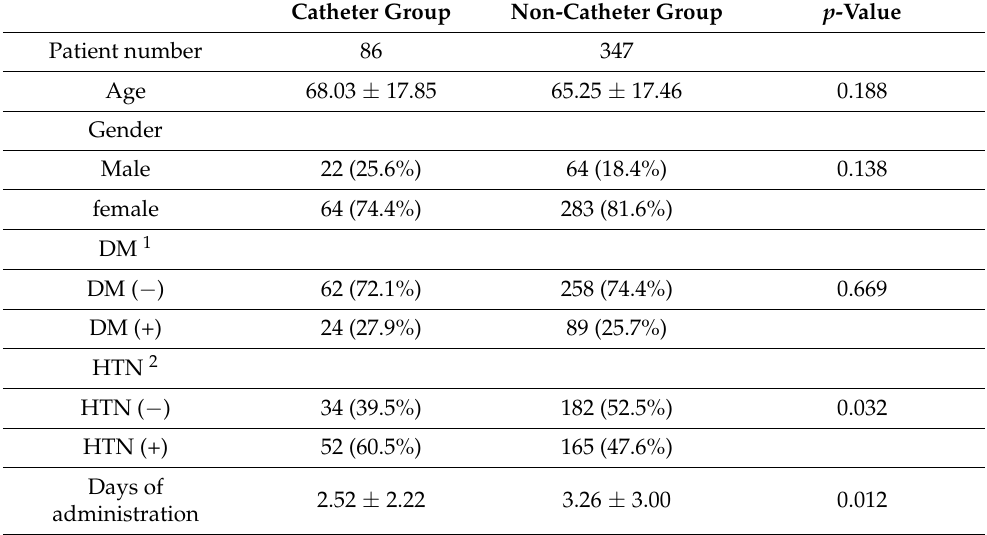
Table 1. Characteristics of study cohort.